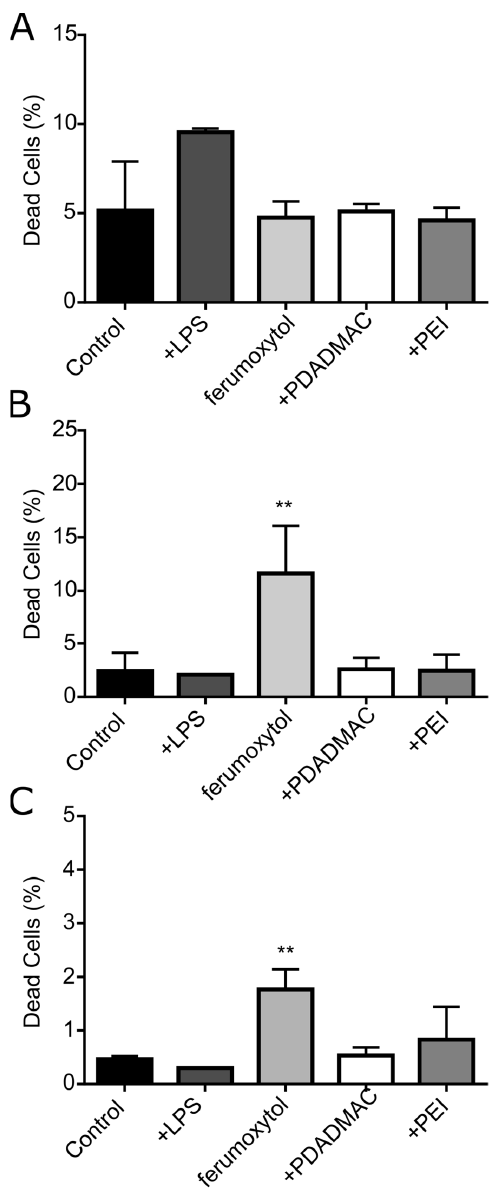
Figure 5. Cytocompatibility of uncoated and PE-coated ferumoxytol in inflammatory and steady-state DCs. Cellular toxicity was analyzed 24 h after MNP labeling and magnetic sorting using Zombie Aqua staining and analysis by flow cytometry. Bar diagrams show the percent of dead cells in ( A ) GM-DCs, ( B ) FL-DC derived cDCs, and ( C ) FL-DC derived pDCs. Mean values ± SD ( n = 3) are plotted (** p < 0.01).